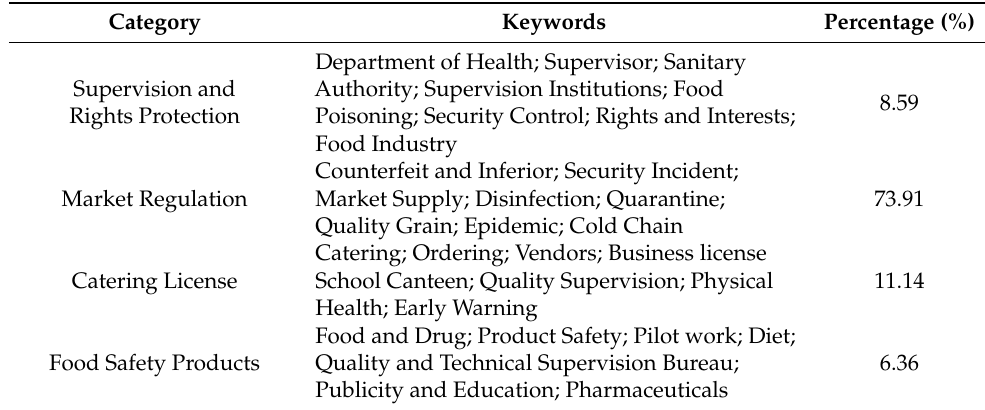
Table 4. The keywords and percentages in the categories of cluster